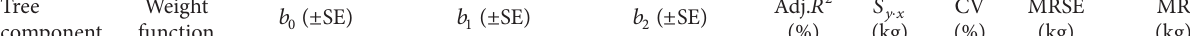
Table 5: Regression coefficients and goodness of fit statistics for the best linear and nonlinear models in (3) and (4), respectively.